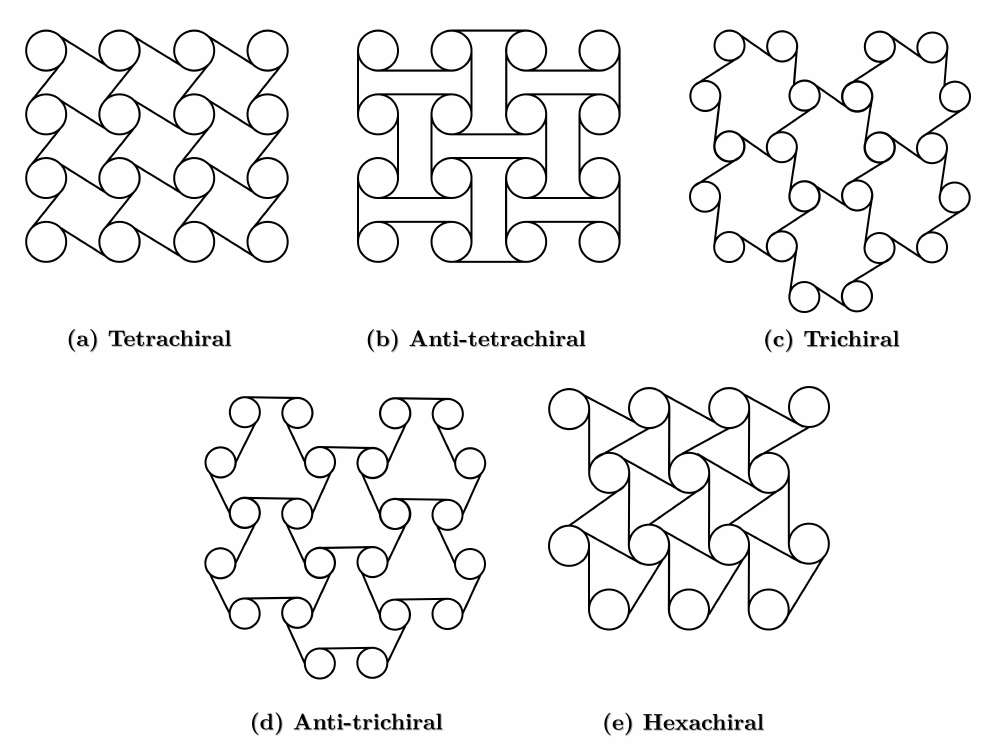
Figure 15. Chiral AXSs: ( a ) tetrachiral; ( b ) anti-tetrachiral; ( c ) trichiral; ( d ) anti-trichiral; and ( e ) hex- achiral structures.